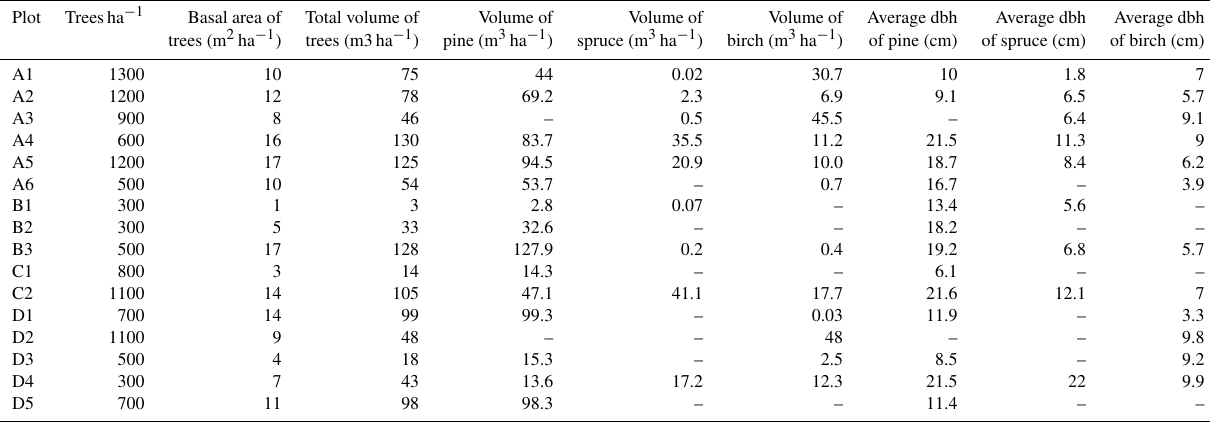
Table 1. Tree species composition of the research plots (dbh = diameter at breast height). Plot Treesha − 1